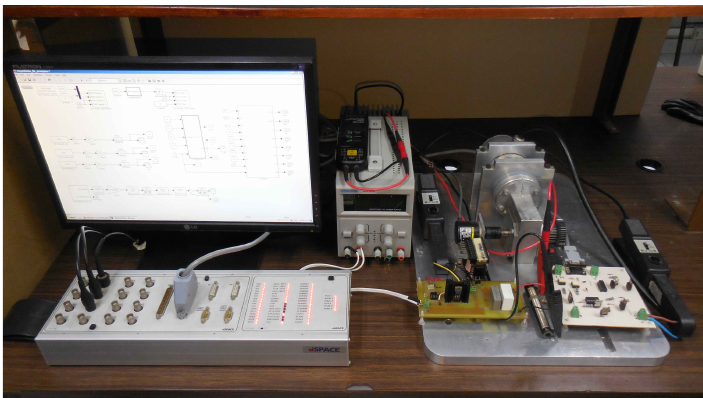
Figure 4. Prototype used to obtain the experimental